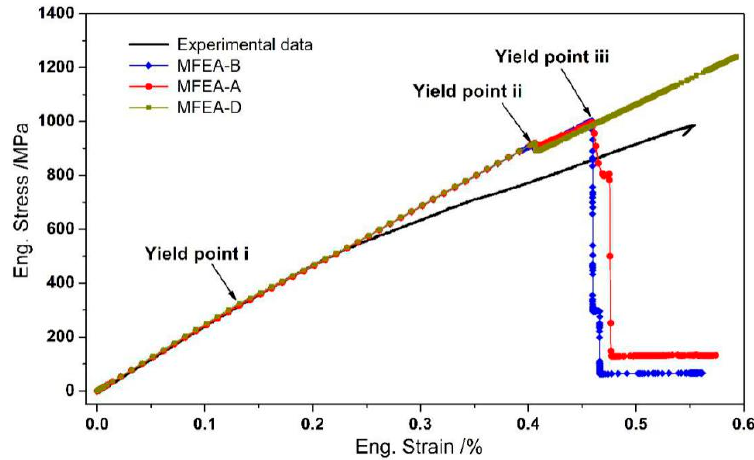
Figure 10. Experimental and calculated stress ‒ strain curves in the longitudinal tensile process.